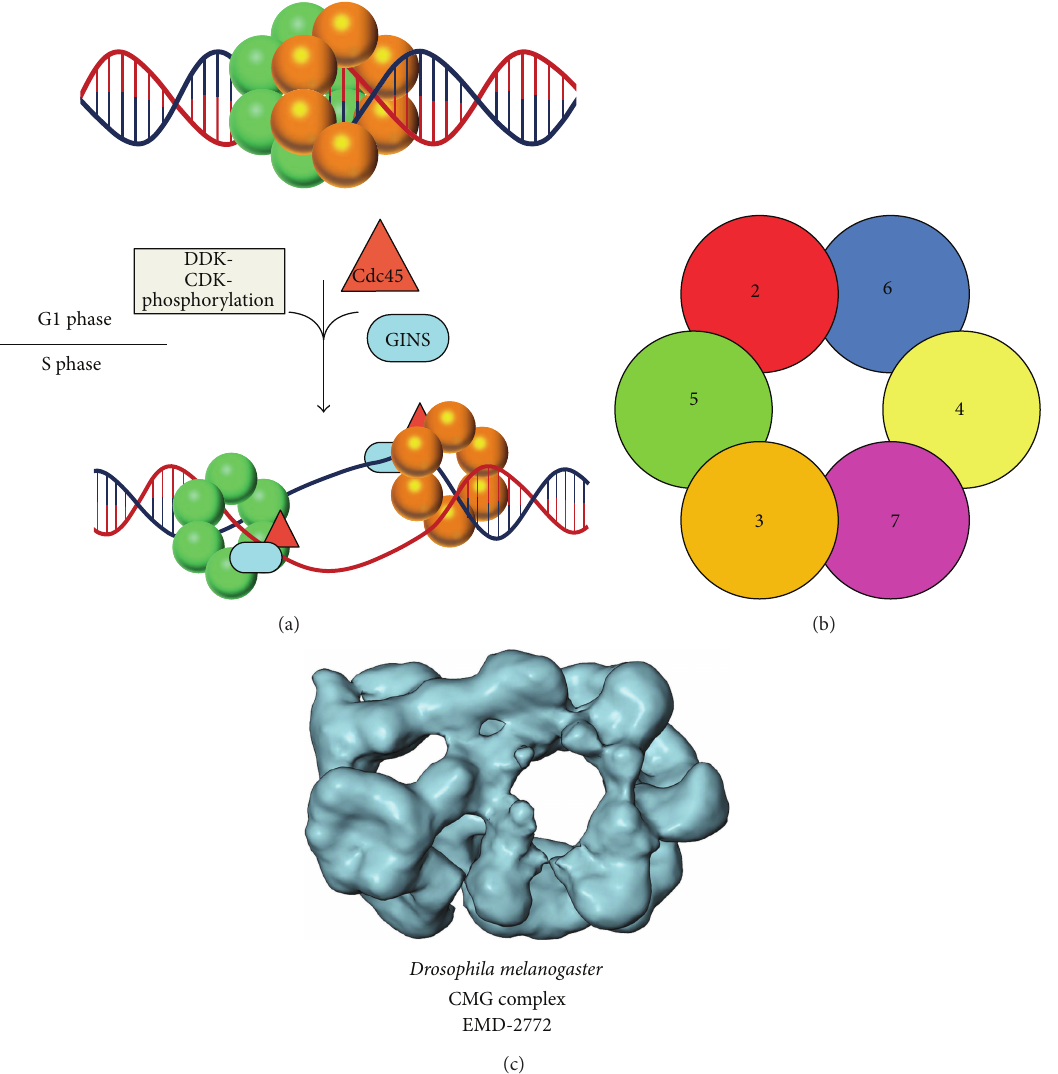
Figure 1: Mcm2–7 activation and organization. (a) Mcm2–7 rings are loaded as inactive double-hexamers at origins of replication by the Origin Recognition Complex (ORC), Cdc6, and Cdt1 (not shown). In a cell-cycle dependent fashion, the Dbf4-dependent Cdc7 kinase (DDK) andcyclin-dependentkinases(CDKs)drivetheassociationofCdc45(redtriangle)andtheGINScomplex(blueoval)withthephosphorylated Mcm2–7 ring to yield the active replicative helicase complex, termed the CMG complex (Cdc45-Mcm2–7-GINS). (b) Schematized view of the Mcm2–7 ring from the N-terminal face with subunits labeled to illustrate the order of subunits around the ring [65, 86]. The ring orientation has been selected to correspond with the orientation of the CMG complex shown in (c). (c) The three-dimensional electron microscopy reconstruction of the CMG complex illustrates basic architectural features. The CMG structure representation was prepared with the UCSF Chimera software package [87] and has been labeled with the Electron Microscopy Data Bank (EMDB) accession